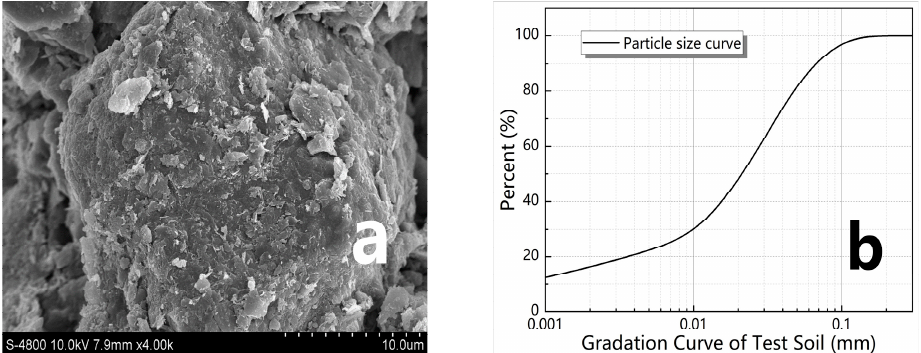
Figure 1. Soil structure and gradation. ( a ) SEM of the soil structure; ( b ) gradation curve of